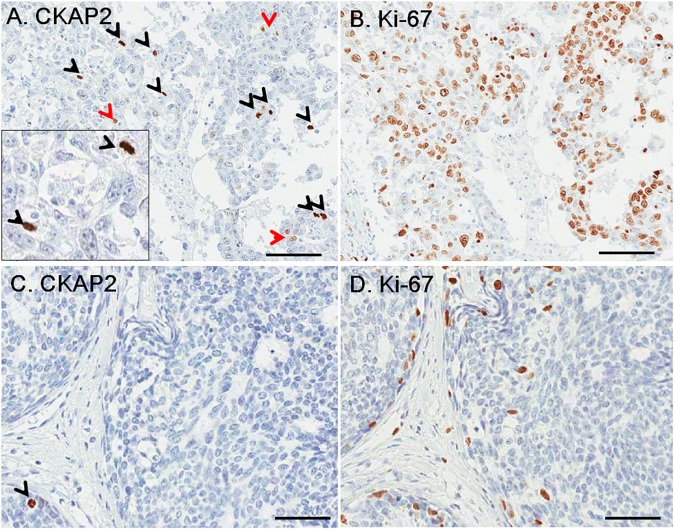
Immunohistochemical staining for CKAP2 and Ki-67 in breast cancer tissues.A case with higher CKAP2-positive cells (A) showed higher Ki-67-positive cells (B). A case with lower CKAP2-positive cells (C) showed lower Ki-67-positive cells (D). The black arrow heads indicate cells with positive chromatin CKAP2 staining. The red ones indicate post-cytokinetic cells. Higher magnification for CKAP2 staining was shown in the box for A. One hundred μm rulers are shown.